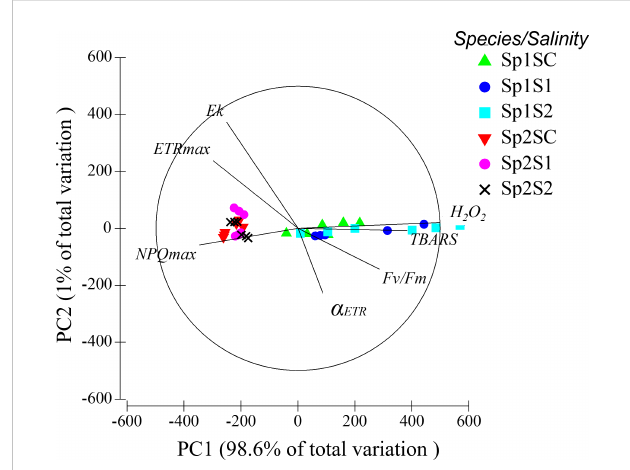
FIGURE 6 Principal component analysis linked to photosynthetic ( F v /F m , a ETR , ETR max , Ek ETR and NPQ max ) and oxidative stress (H 2 O 2 and TBARS) parameters in D. kunthii and D. dichotoma transplants from brine discharge from a desalination plant. D. kunthii (Sp1) and D. dichotoma were transplanted in 2 impacted sites with low (S1) and high (S2) in fl uence and control site